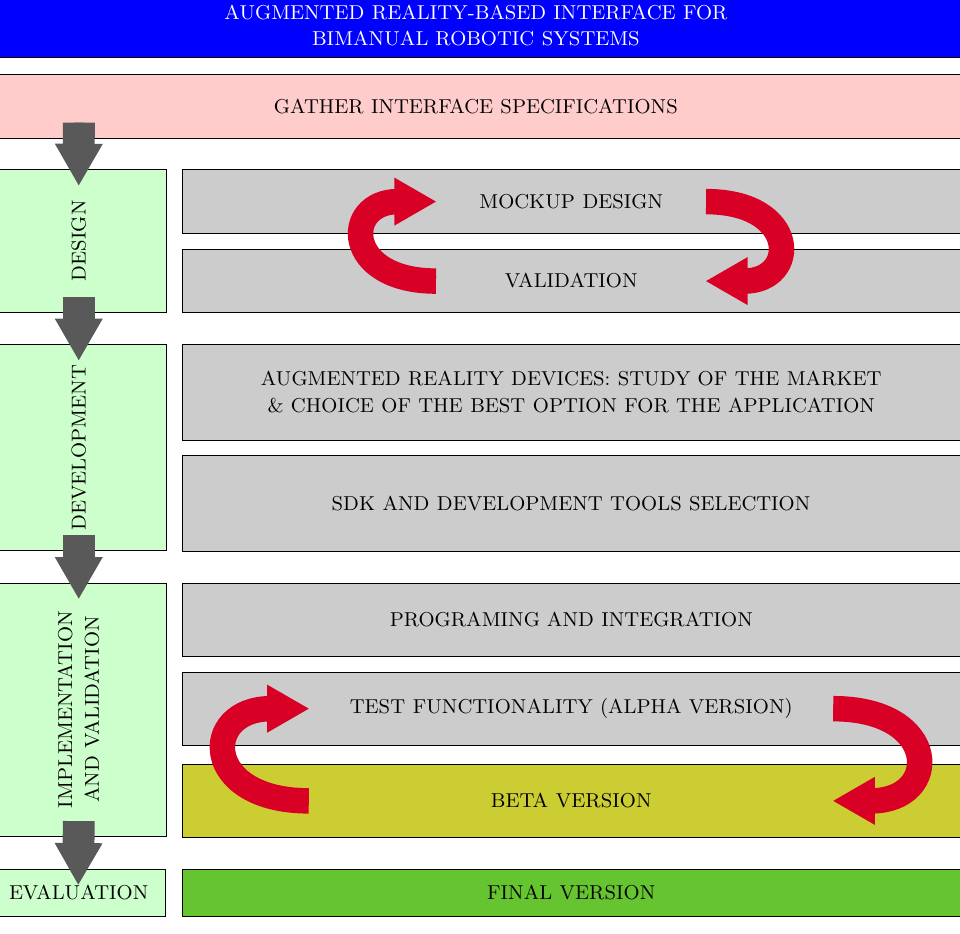
Figure 5. Flowchart of the methodology proposed in this work for designing the AR-based interface.